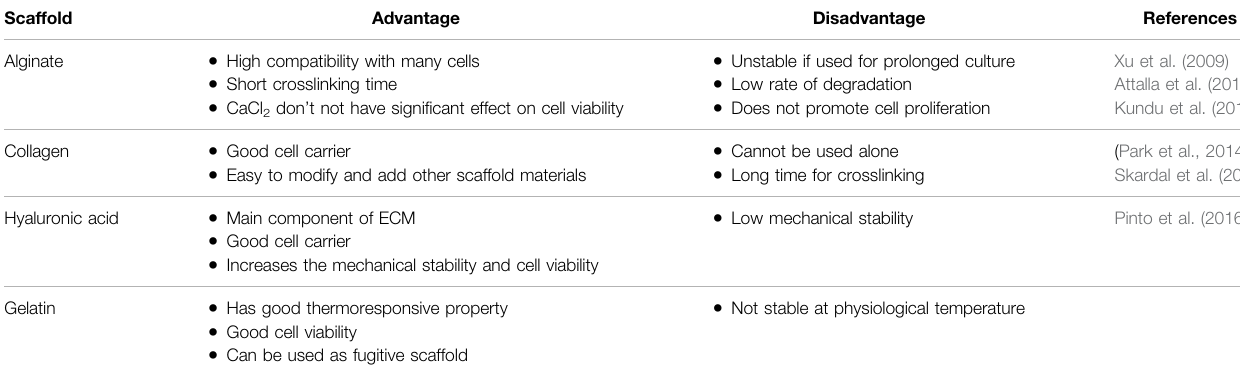
TABLE 2 | Advantages and disadvantages of scaffold biomaterials used for 3D bioprinting of cardiovascular tissues.